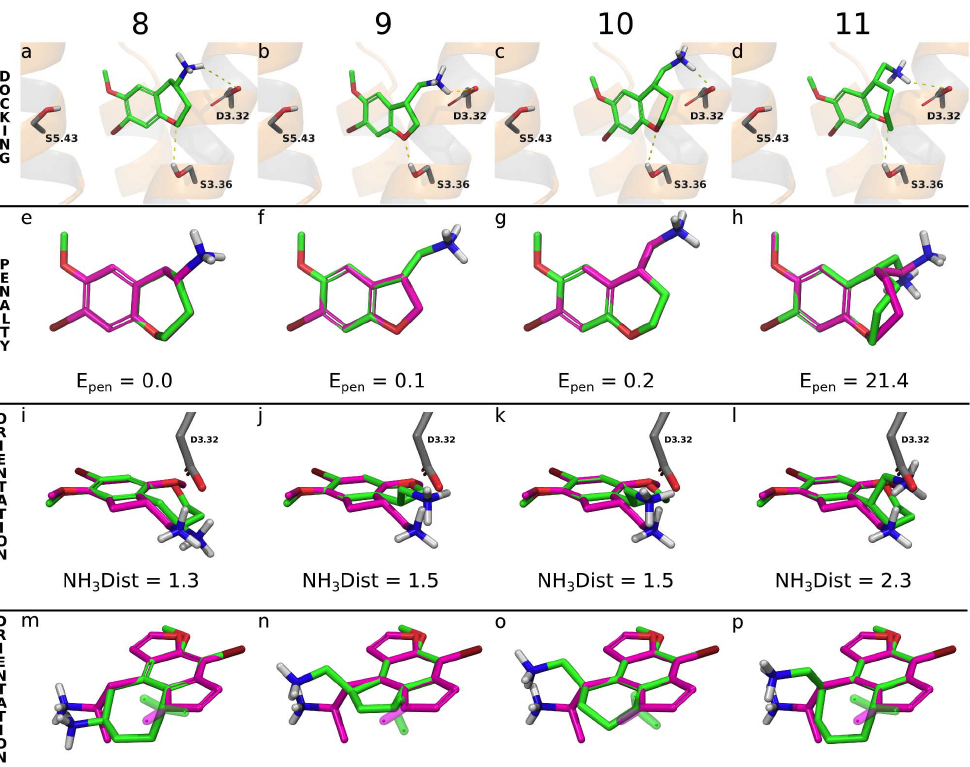
Figure 6. Ligand docking and conformational analyses. a-d) Docking poses for 8 2 11 the 5-HT 2B crystal structure. 8 2 11 have similar contacts as the reference compounds 4 and 5 for the charged amine, and phenyl ring, whereas the 4-bromo points deeper and closer to A5.46 225 . e-h) The docked poses of 8 2 11 (green carbons) overlaid on their calculated lowest energy conformations (magenta carbons). 11 has a high conformational energy penalty, E pen (21.4 kJ/mol) upon binding, which is consistent with its lack of or low affinity for 5-HT 2A-C . i-l) Comparison of the positions of the amine side chains of 8 2 11 (green carbons) superimposed onto the docked reference 5 (magenta carbons). NH 3 Dist is the distance (A˚) between the amines of 8 2 11 , respectively, and 5 . The distance is greatest for 11 , indicating a conformationally strained amine side chain upon binding. m-p) Comparison of the lone pair orientations of the 2-oxygens of 8 2 11 (green carbons) and 4 (magenta carbons). The lone pair vectors (semi-transparent sticks) of 8 2 11 all differ significantly from 4 . All superimpositioning (Fig. 6e-p) was made on the phenyl, bromine, 2-oxygen and 5-oxygen atoms.